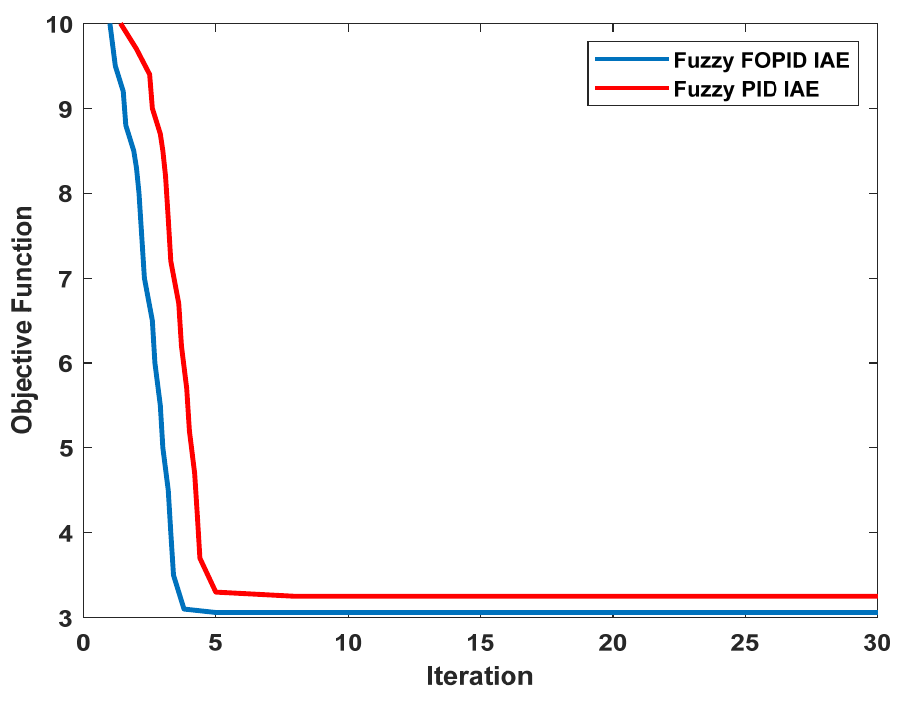
Figure 13. The convergence of the PSO.